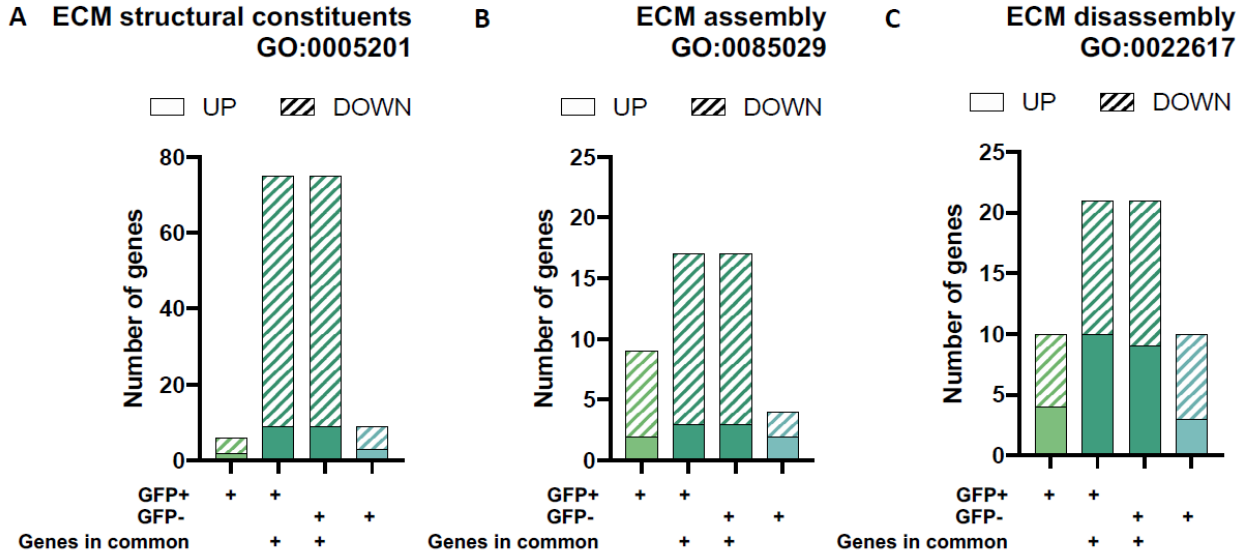
Figure 6. Differential gene expression for gene-sets associated with extracellular matrix (ECM) architecture and remodelling. The proportion of up- and down-regulated differentially expressed genes (DEGs) in each of the four unique/overlapping gene profiles (GFP+ group only, overlapping genes in GFP+ cells, overlapping genes in GFP − cells and GFP − group only) were assessed using functional annotation gene-sets related to extracellular matrix remodelling (ECM) from the Gene Ontology Biological Processes database (GO2018 BP): ECM structural constituents ( A ), ECM assembly ( B ) and ECM disassembly ( C ).